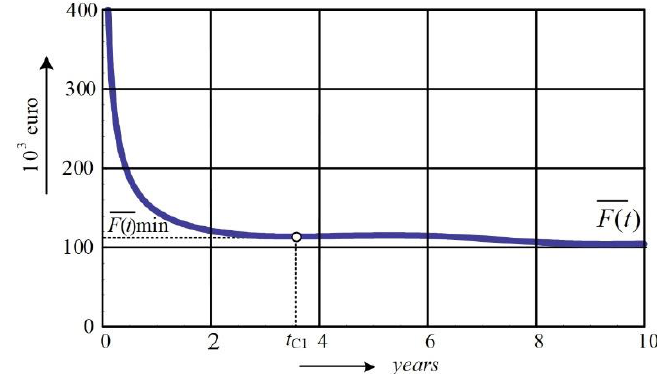
Figure 5. The function of average costs for the machine type 1.